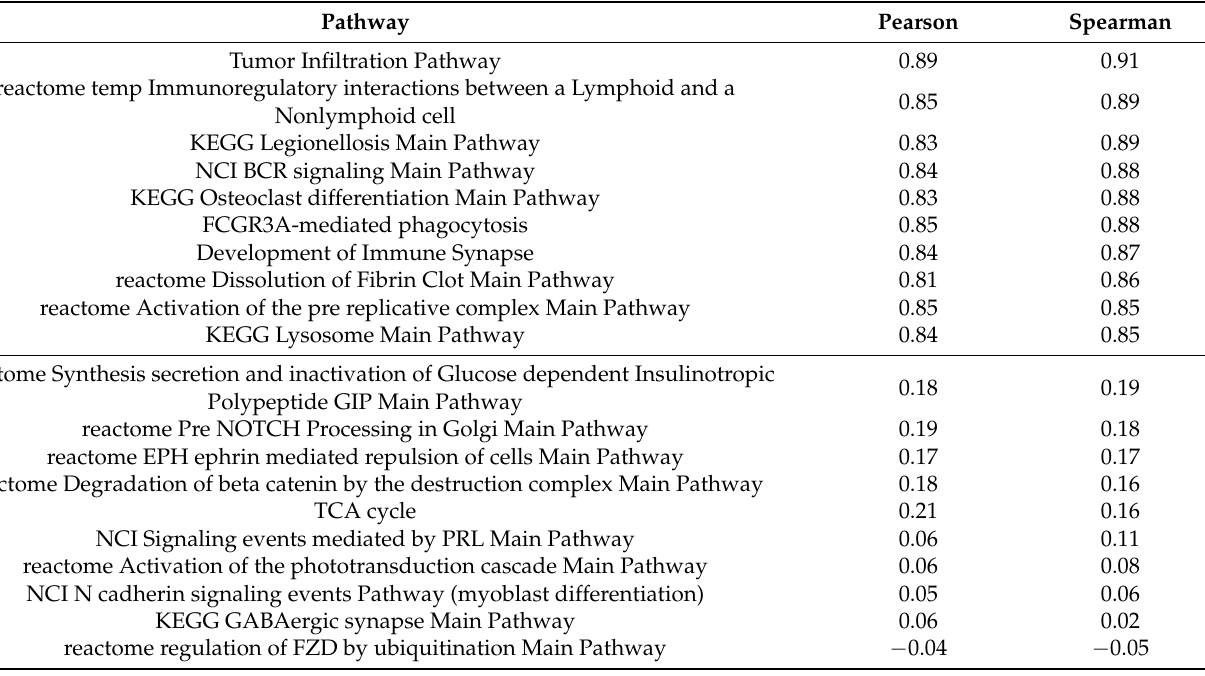
Table 2. “Top-10” of the most and the least correlated molecular pathways between RNA and protein expression data calculated for Glioblastoma Multiforme